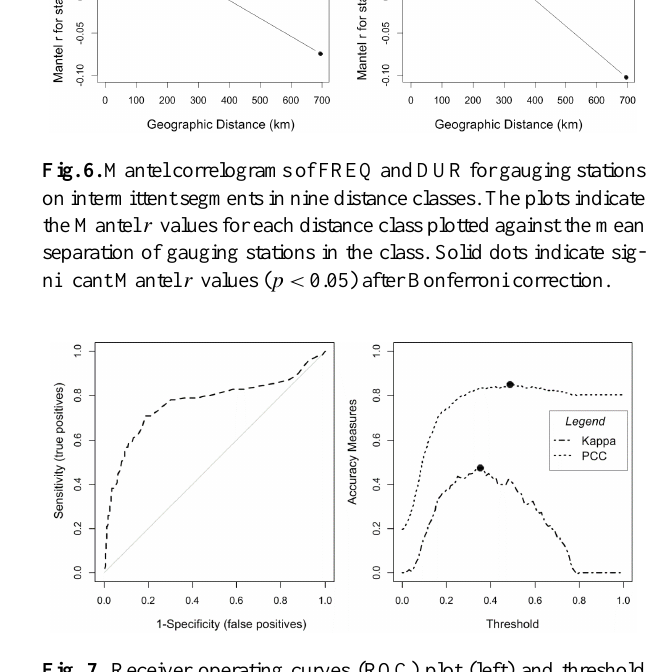
Fig. 7. Receiver operating curves (ROC) plot (left) and threshold plot (right) for the flow-regime classification. The black circles on the threshold plot indicate the probabilities thresholds that maxi- mize the classification performance as measured by Cohen’s kappa and the percent correctly classified